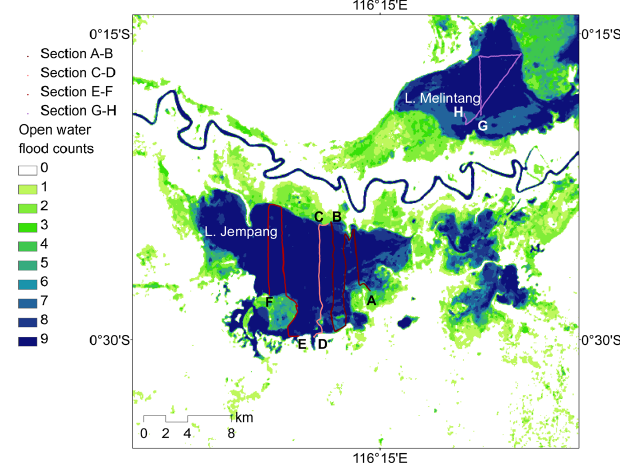
Fig. 10. Bathymetry measurement track in Lake Jempang and Lake Melintang plotted on the flood occurrence map from nine PALSAR images in 2008 and